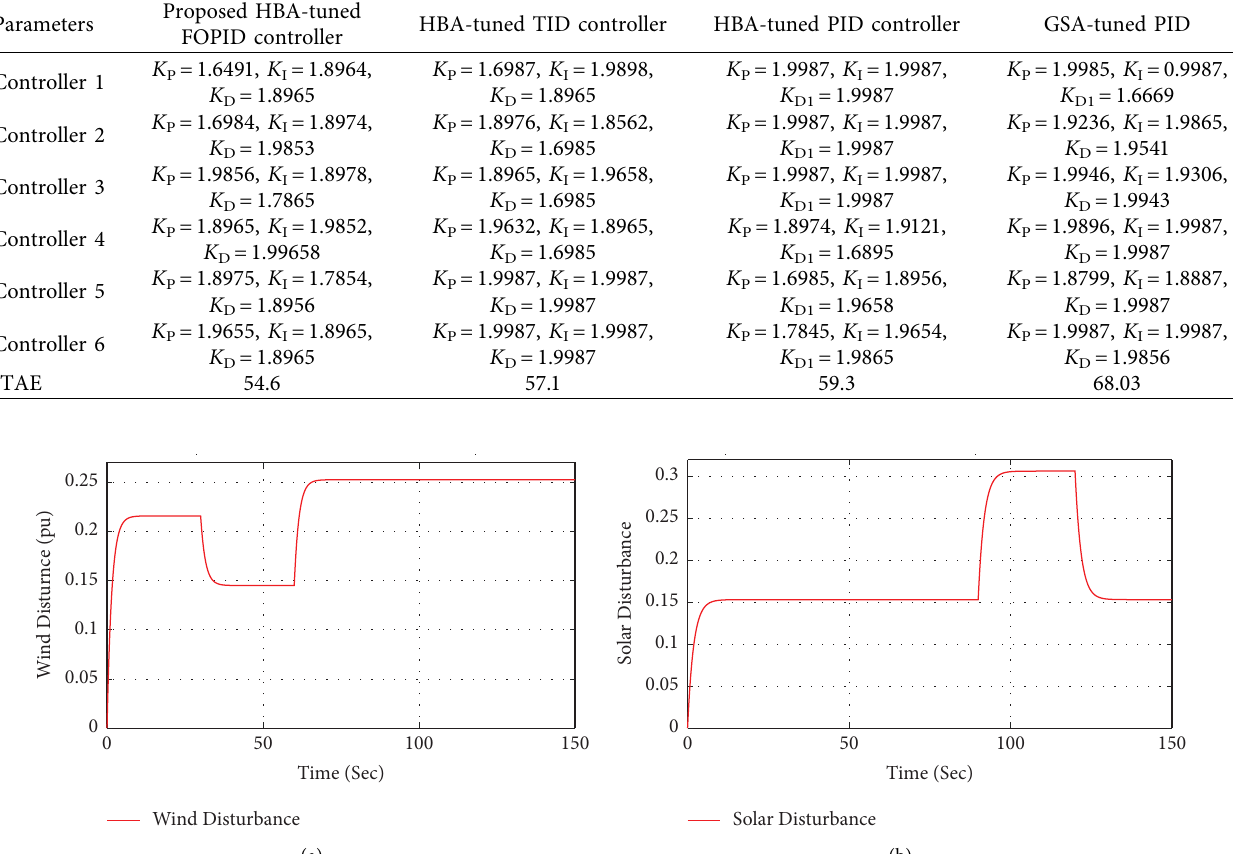
Figure 4: (a andb) Diferent disturbances of the hybrid power system. (a) Wind disturbance for area 1. (b) Solar disturbance for area